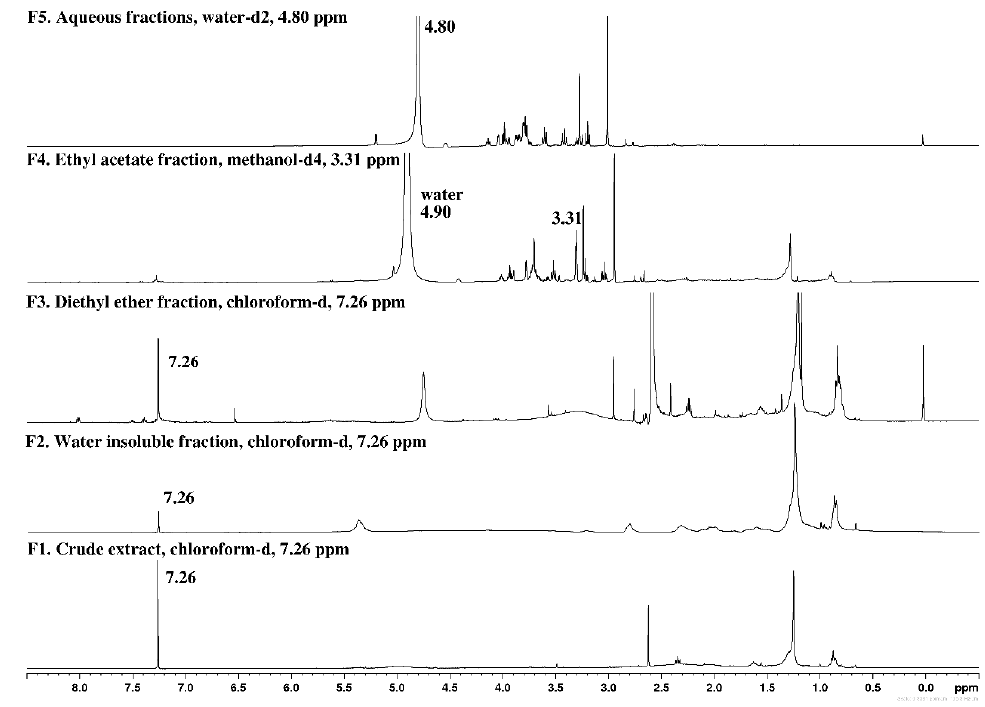
Figure 1. 1 H NMR (400 MHz) spectra of Gelidium corneum fractions (F1–F5).